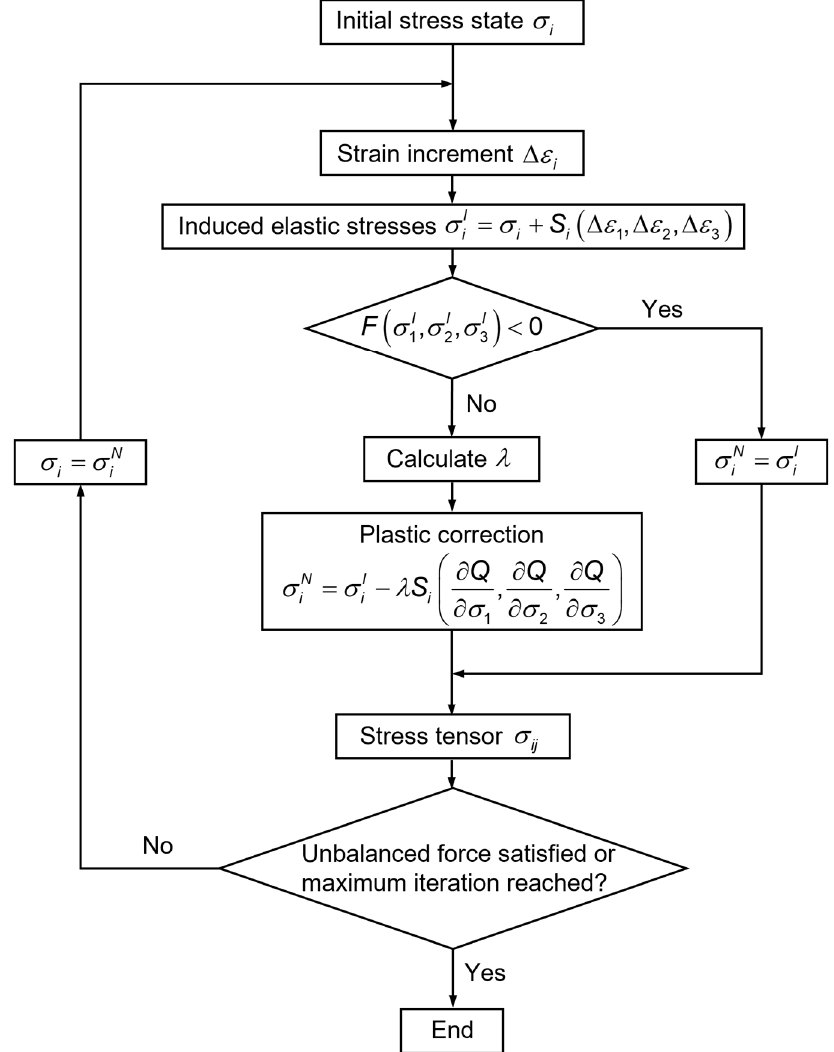
Figure 2. Computational scheme for the implementation of the non-associated MSDP u -EPP model in FLAC3D.